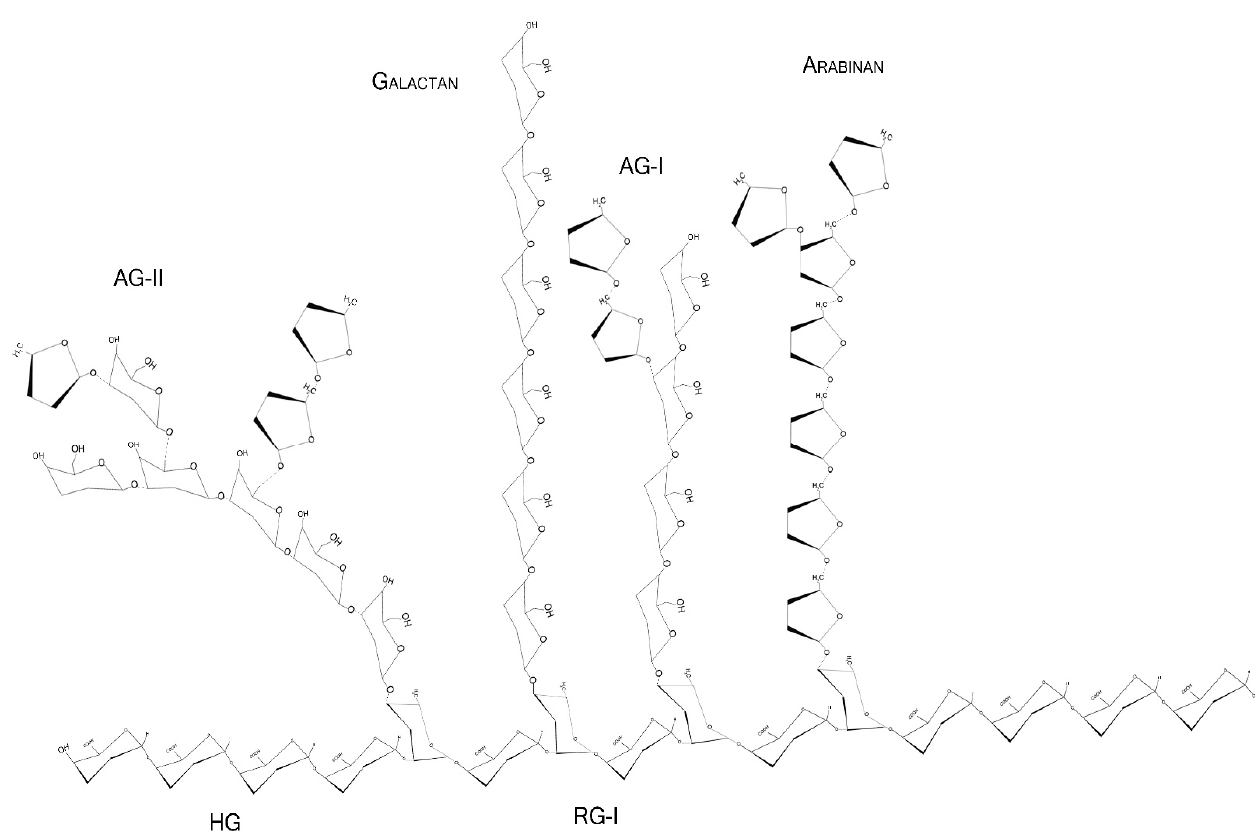
Figure 1. Schematic representation of major pectin components in chair conformation. HG— homogalacturonan, composed of linear α -1,4- D -galactopyranuronic acids; RG-I—intercalated α - D - galactopyranuronic acids and α - L -rhamnopyranose through α -1,4 and 1,2 glycosidic bindings; AG-I— β -1,4- D -galactopyranose with occasional O -3 α - L -arabinofuranose; AG-II— β -1,3- D -galactopyranose with O -6 α - L -arabinofuranose/arabinogalactans. Arabinans and galactans consist of linear α -1,5- L - arabinofuranoses and β -1,4- D -galactopyranoses, respectively.